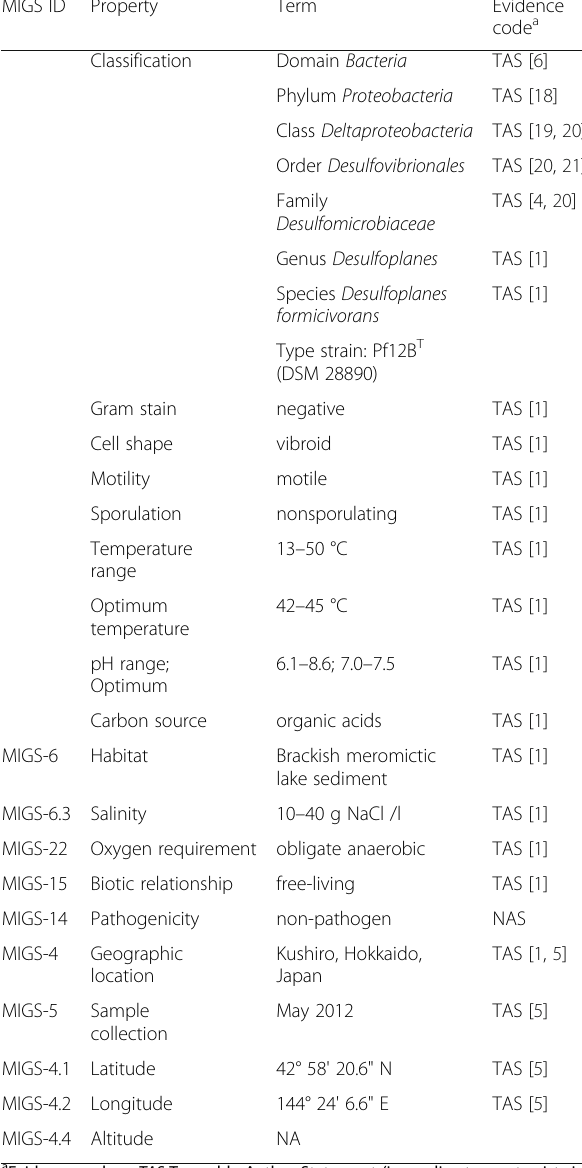
Table 1 Classification and general features of Desulfoplaens formicivorans strain Pf12B T according to MIGS